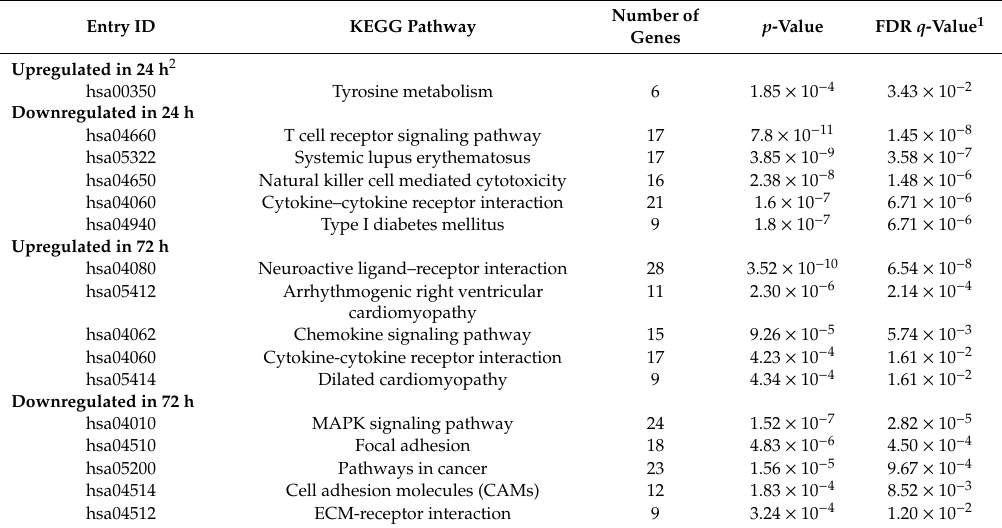
Table 2. Top five KEGG pathways significantly enriched in TC compared to MTA in a time-dependent manner.